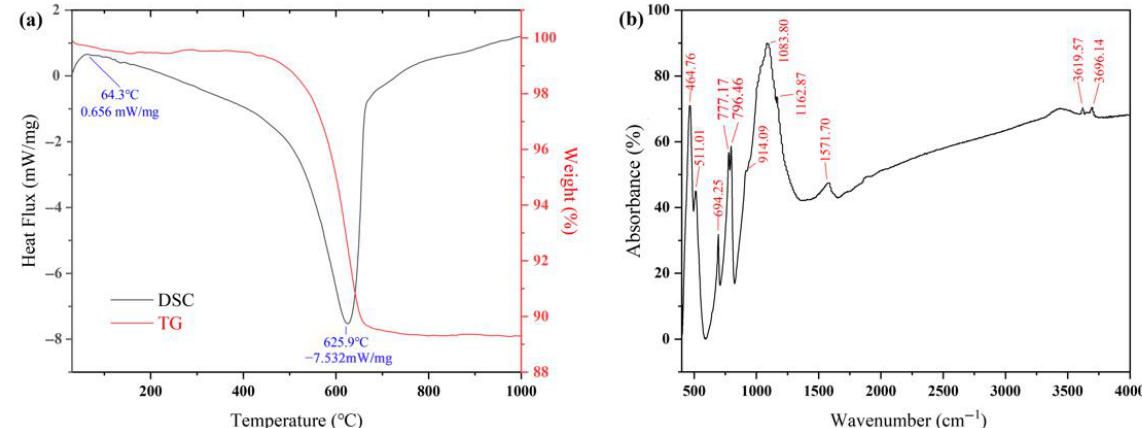
Figure 3. ( a ) DSC-TG curves and ( b ) FTIR spectra of the ore sample.